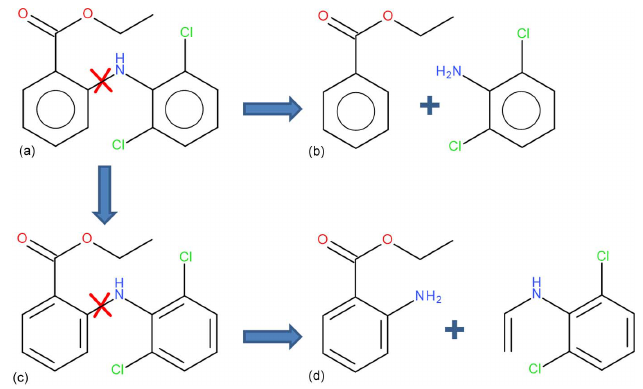
Figure 7 Absolute difference in X —H bond lengths for HAR with and without fragmentation. Each bond is represented with (1) a dark blue circle in the case of the more coarse fragmentation scheme and (2) a red diamond for the fragmentation scheme with overlapping fragments that avoids breaking amide bonds. The green stars correspond to X —H bonds in the scheme with overlapping fragments which lead to amide bond breaking. Structure ID ( x axis) refers to the labelling scheme in Fig. 6.